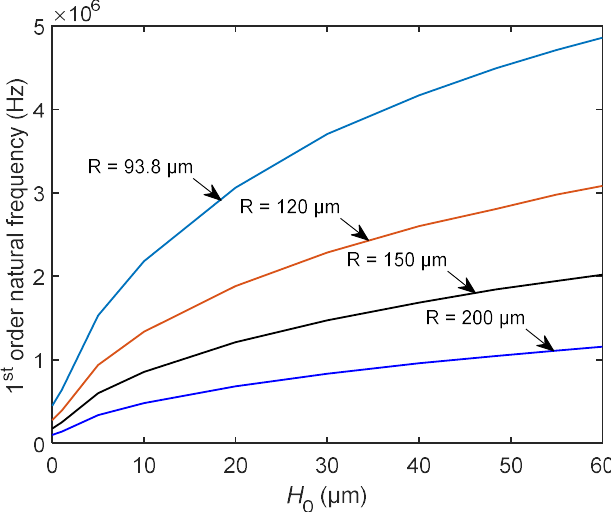
Figure 11. The variation of the first natural frequency of the bionic structure with the height H 0 for different R .